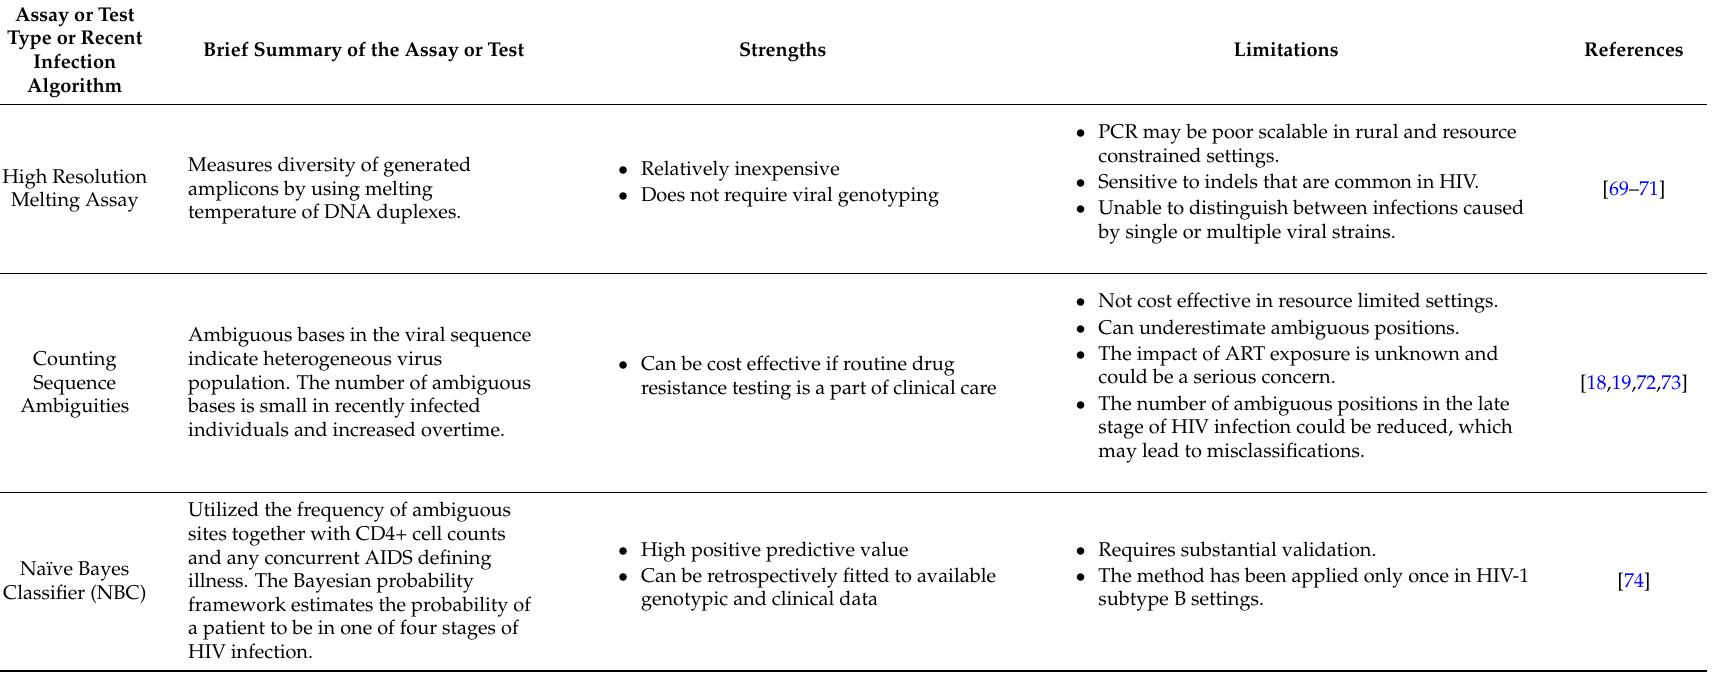
Table 1. Comparison of the molecular based approaches for determination of HIV